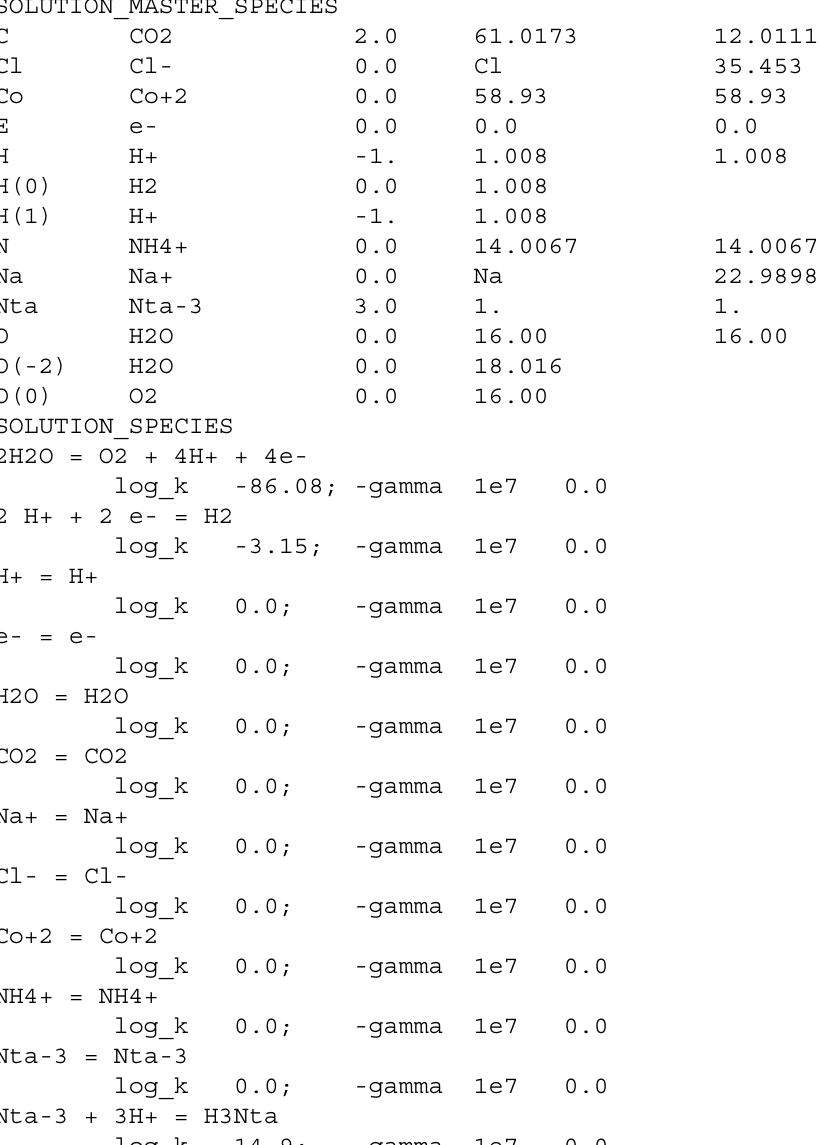
Table 39. Database for example